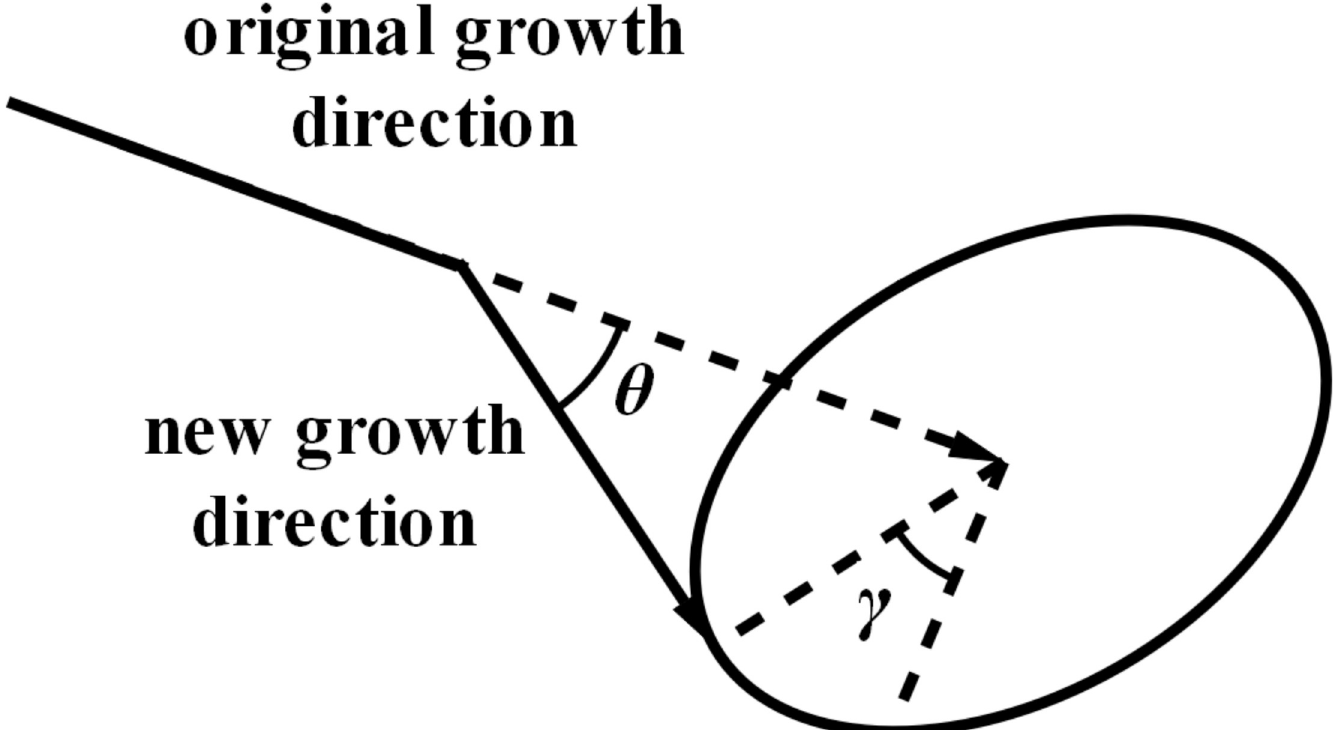
Fig 11. Root growth